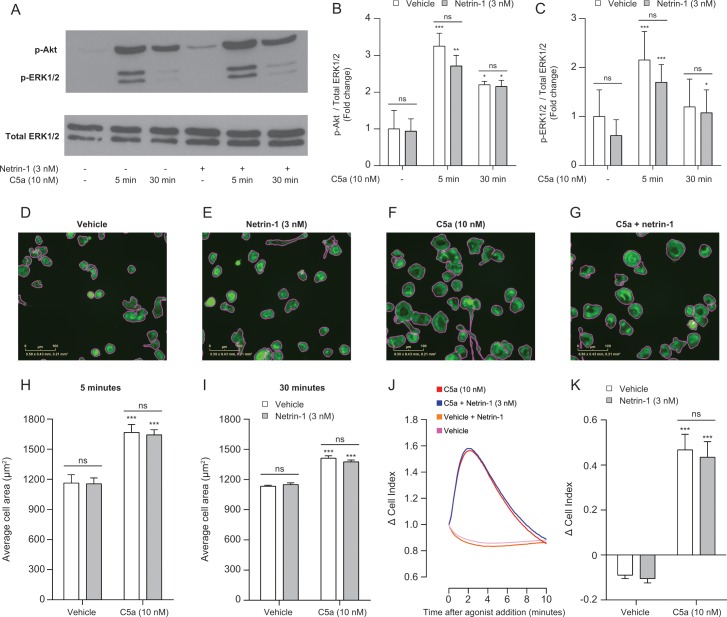
Netrin-1 does not affect distal signalling events following C5aR1 ligation.(A) BMDMs were seeded into 6 well dishes (2x106 cells/dish) and then treated with either vehicle or 3 nM netrin-1 for 45 min at 37°C, 5% CO2. Cells were then stimulated with either vehicle or 10 nM C5a for 5 or 30 min at 37°C, 5% CO2. Cell lysates were prepared and western blotting conducted for either phosphorylated Akt (p-Akt) or ERK1/2 (p-ERK1/2), followed by stripping and re-staining for total ERK1/2 as a loading control. Quantification by densitometry of C5a-induced (B) Akt or (C) ERK1/2 phosphorylation. Data are mean + SEM, n = 3 biological replicates. BMDMs were seeded into 96 well black walled plates (5000 cells/well) and then treated with either vehicle or 3 nM netrin-1 for 45 min at 37°C, 5% CO2. Cells were then stimulated with either vehicle or 10 nM C5a for 5 or 30 min before being fixed and stained with Alexa Fluor® 488 phalloidin to visualise F-actin. Images were then taken using an IncuCyte® ZOOM microscope and the average cell area calculated. Representative images showing phalloidin staining in green and the cell outlines calculated by the IncuCyte® ZOOM software in pink for cells stimulated with (D) vehicle alone, (E) 3 nM netrin-1 alone, (F) 5 min 10 nM C5a alone and (G) 3 nM netrin-1 and 5 min 10 nM C5a. Quantification of average cell area after (H) 5 min or (I) 30 min stimulation. Data are mean + SEM, n = 3–5 biological replicates with 4 technical replicates per condition. (J) BMDMs (2 x 104) were placed into a 96 well E-plate allowed to adhere for 2–3 hours at 37°C, 5% CO2. Afterwards, cells were treated with either vehicle or 3 nM netrin-1 for 45 min prior to being stimulated with vehicle or 10 nM C5a. (K) Quantification of the change in cell index following stimulation. Data are mean + SEM, n = 4 biological replicates with 3–4 technical replicates per condition. Statistical analysis was conducted by two-way ANOVA with Sidak’s multiple comparisons correction. ns P > 0.05, for indicated comparisons. * P < 0.05, ** P < 0.01, *** P <0.001 compared to the respective vehicle control.